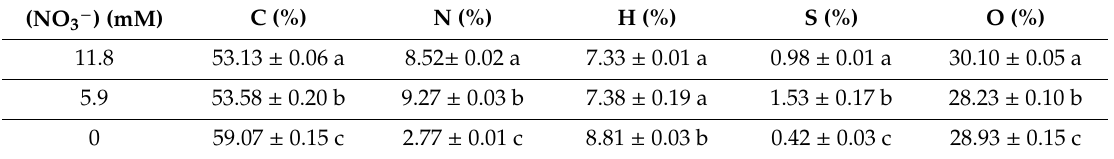
Table 6. E ff ect of the initial nitrate concentration on the elemental composition of the